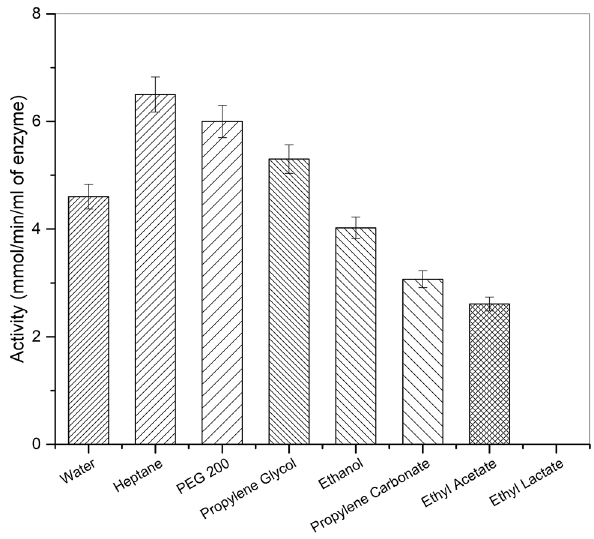
Figure 1. Activity of alpha-amylase in various solvents analysed by employing 1 ml each starch (10 mg/ml) and enzyme (50 mg/ml) solutions incubating at 30 °C at pH 6.9 for 10